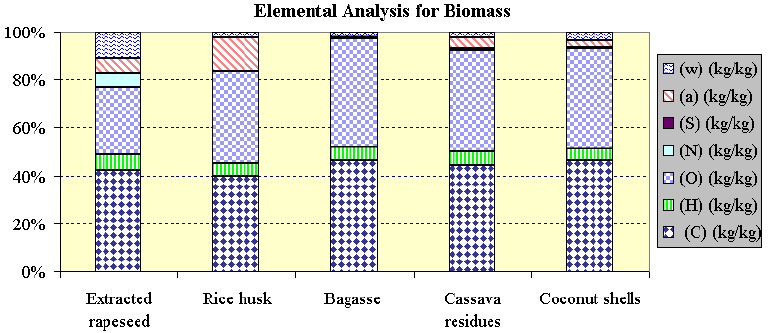
Figure 1. Comparison between the chemical compositions of biomass fuels.